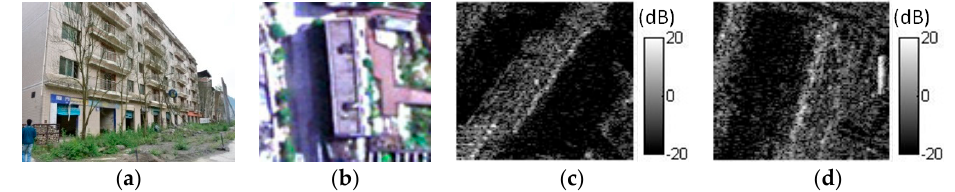
Figure 1. A standing building: ( a ) in situ photograph; ( b ) optical image acquired in 2013; ( c ) TerraSAR-X staring spotlight (ST) ascending SAR image (the azimuth direction is from bottom to top, and the range direction is from left to right); ( d ) TerraSAR-X ST descending SAR image (the azimuth direction is from top to bottom, and the range direction is from right to left).